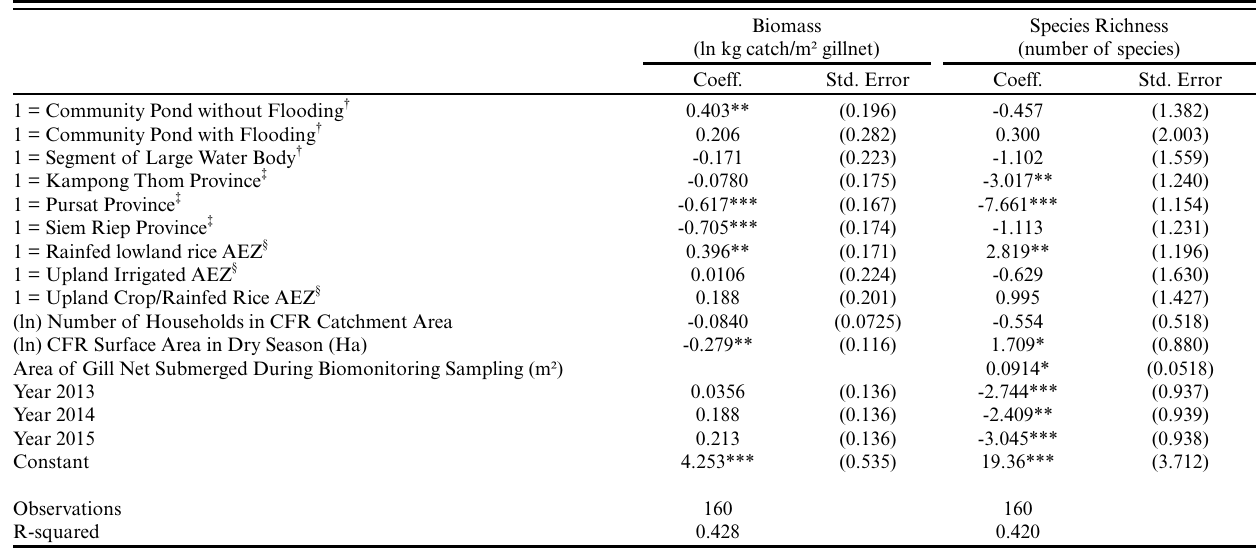
Table 1 . Relationships between community fish refuge (CFR) characteristics and biomass and species richness. The results from longitudinal regression models of relationship 1, which examines the association between CFR characteristics and the quantity of fish, or biomass, and biodiversity, or species richness, of those fish from 2012 to